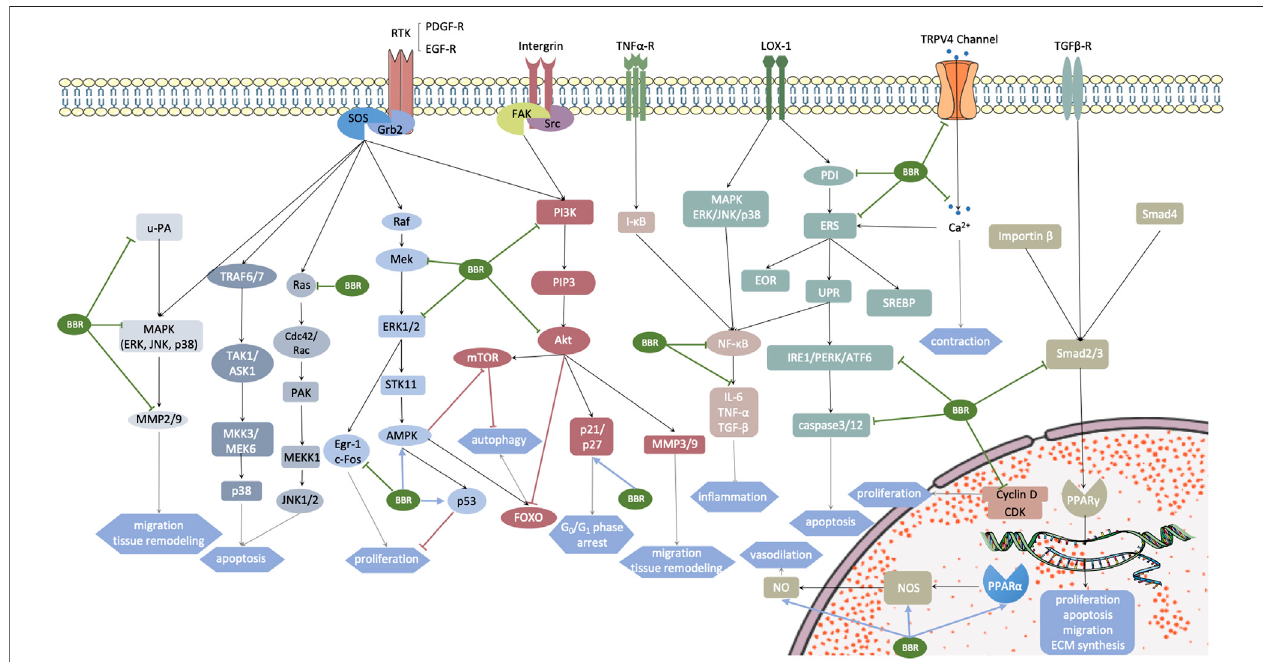
FIGURE3| Aberrantlyactivatedsignalingpathwaysinvascularsmoothmusclecells(VSMCs)undersomepathogenicconditions.Targetsofberberinearemarked with arrows. The motivated receptors involve transmembrane receptors RTK, integrin, TNF- α , TRPV4 channel, LOX-1, TGF- β R, and nuclear hormone receptor PPAR α . These receptors stimulate multiple downstream signaling pathways, promoting a cellular cascade reaction and gene transcription, which subsequently leads to cardiovascularremodeling. Grb2,growthfactorreceptor-bound protein2;SOS,SonofSevenless;u-PA,urokinase-typeplasminogenactivator;ERK,extracellular regulated protein kinase; JNK, c-Jun N-terminal kinases; P38, P38 MAPK; MMP, matrix metalloproteinase; TRAF6/7, TNF receptor associated factor 6/7; TAK1, transforminggrowth factor- β -activated kinase 1;ASK1, apoptosis signal-regulating kinase1; MMK3/MEK6,MAPkinase 3/6;Ras, afamily ofsmall GTPase; Cdc42, cell devision control protein 42; PAK, p21-activated kinase; MEKK1, MEK kinase 1; Raf, Raf kinases; Mek, MAPK/ERK kinase 1/2; Egr-1/c-Fos, MEK/ERK-dependent transcription factors, which are related with growth factor activation and cell cycle re-entry; STK11, also known as LTB1, serine-threonine kinase 11; AMPK, AMP- activated protein kinase; PDGF-A, platelet-derived growth factor-A; FAK, focal adhesion kinase; Src, sarcoma; PI3K, phosphoinositide 3-kinases; PIP3, phosphatidylinositol (3,4,5)-trisphosphate; NF- κ B, nuclear factor kappa-light-chain-enhancer of activated B cells; IL-6, interleukin-6; TNF- α , tumor necrosis factor- α ; TGF- β , transforming growth factor- β ; Akt, protein kinase B; Bad, Bcl-2 antagonist of cell death; mTOR and FOXO, two main downstream effectors of AMPK related to cell autophagy; PDI, protein disul fi de isomerase; ERS, endoplasmic reticulum stress; EOR, endoplasmic reticulum overload response; UPR, unfolded protein